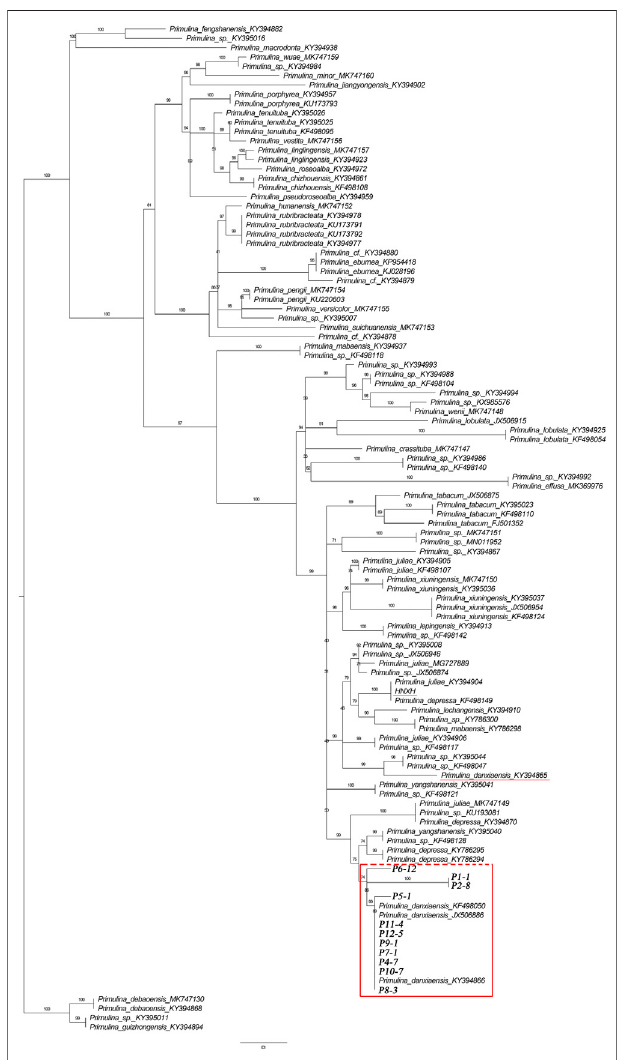
FIGURE3| Phylogenetictreeof109 Primulina speciesconstructedfrom ITS sequences. P1-1 – P12-5: Primulina danxiaensis sampled from Mount Danxia. HNXH: P. danxiaensis sampled from Hunan.